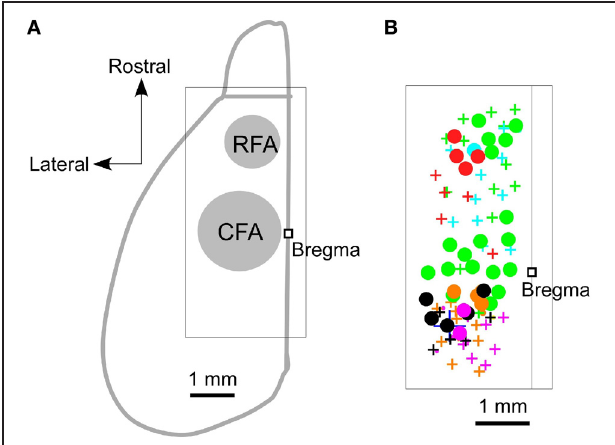
FIGURE 1 | Locations of the RFA and the CFA. (A) A schematic dorsal view of the left hemisphere of the mouse neocortex and olfactory bulb. A square was used to denote the location of the bregma. The approximate locations of the RFA and the CFA are labeled and indicated in gray. The boxed region indicates the expanded area shown in (B) . (B) Circles denote the sites where ICMS induced contralateral forelimb movements, and the crosses denote the sites where the maximum ICMS current injections (200 µ A) failed to induce contralateral forelimb movements. Different colors indicate the different animals that were used in these experiments ( n = 6 mice).